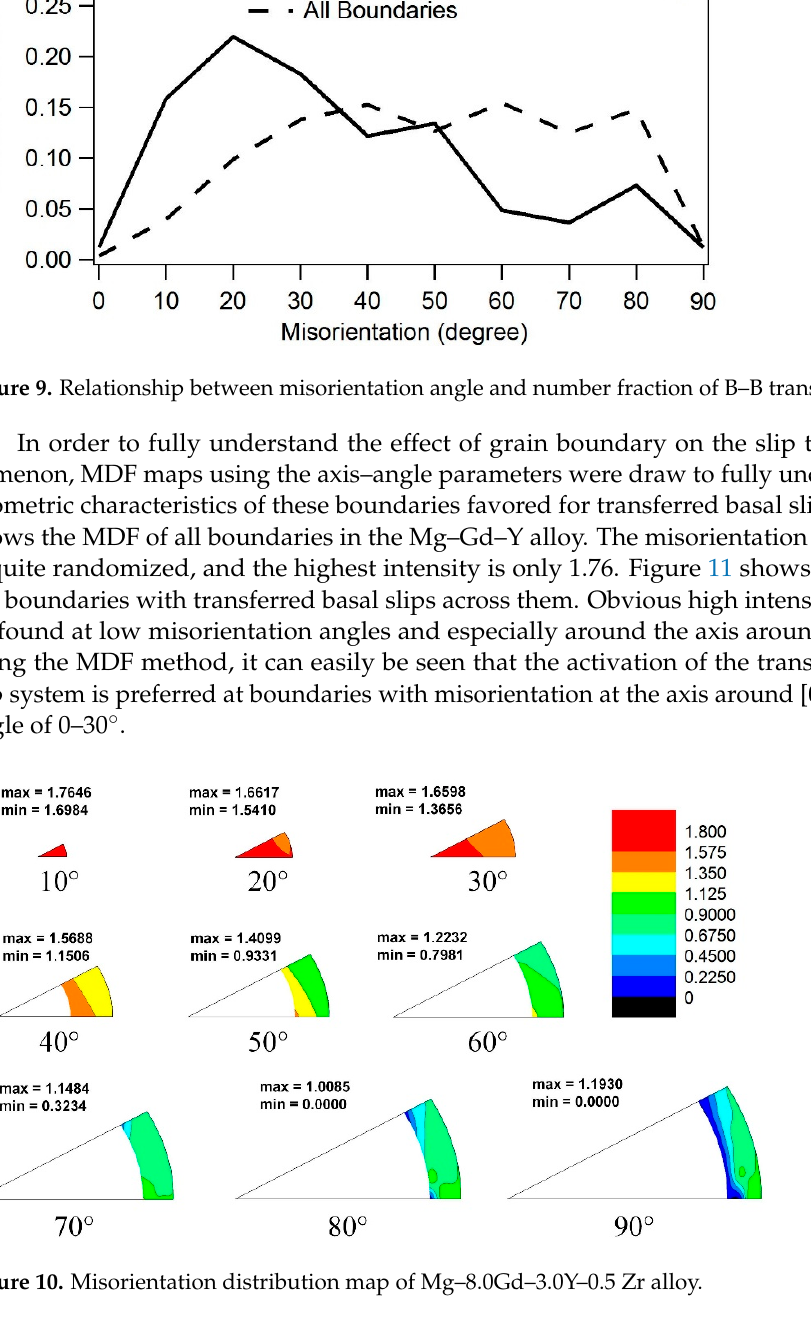
Figure 11. Misorientation distribution map of B–B slip transferred boundaries. 3.4. Effect of Grain–boundary misorientation Distribution on Ductility The grain–boundary area preferred for more slip transfer would accommodate higher strain. If one polycrystalline magnesium alloy has more boundaries of the sort, the ductility of this material, theoretically, should be higher. In order to support the arguments made in the present manuscript, data from two groups of Mg–3Al–1Zn (AZ31) alloy have been included. Figure 12 exhibits two groups of data, all from the Mg–3Al–1Zn (AZ31) alloy, which is the most common of the magne- sium alloys. The manufacturing process for each is different; one involves rolling and the other involves extrusion. These two kinds of material show a similar Schmid factor distri- bution during tension along their prior working (rolling or extrusion) direction. However, the rolled AZ31 alloy shows much higher elongation than the extruded one (Figure 12b, data collected from the literature [17–29]). This phenomenon could not be explained based on the theory that a higher ductility is achieved by grain orientations favored for basal slip.